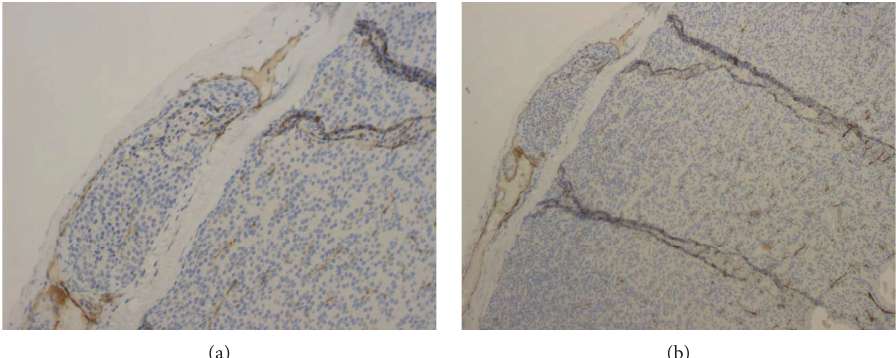
Figure 3: Section of the right inferior parathyroid specimen showing a venous vascular invasion focus highlighted by immunohistochemical staining for CD31 ((a) 20x; (b)